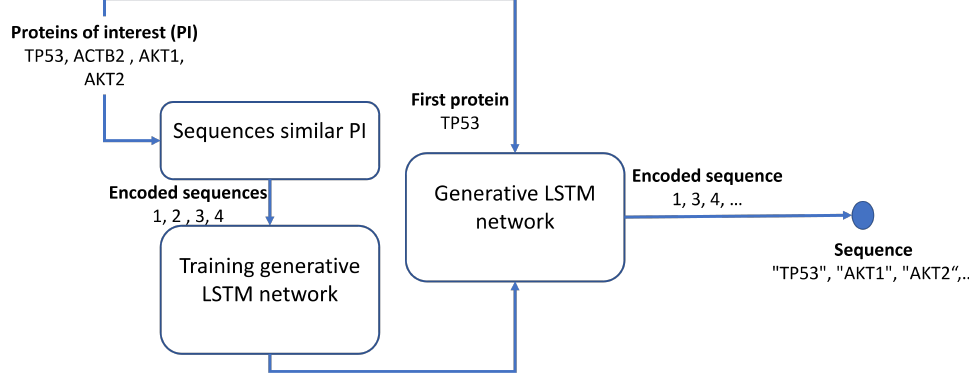
Figure 3. The generative process of protein sequences by bidirectional